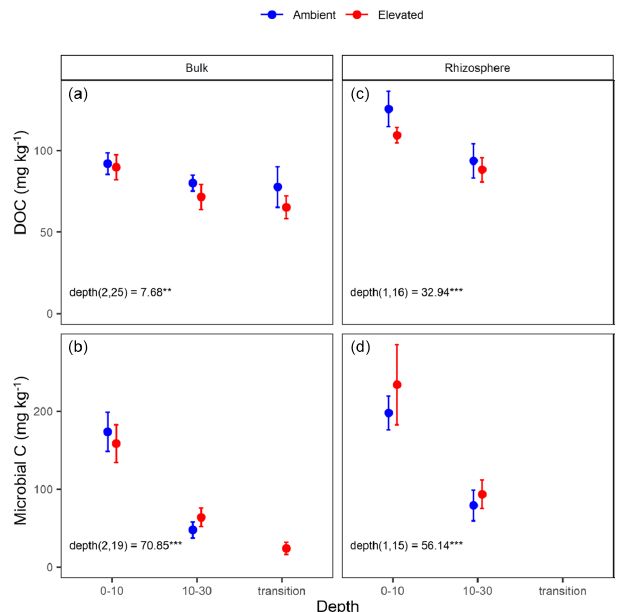
Figure 3. Dissolved organic carbon (DOC) and microbial biomass carbon (C) content for bulk and rhizosphere soil of the mature Euca- lyptus forest soil exposed to ambient (blue) and elevated (red) CO 2 for three depths (0–10 and 10–30cm and transition). Error bars in- dicate the standard error. Mixed-effects model output is stated (de- grees of freedom and Df residuals), the F statistic is presented, and asterisks for the P values for significance are as indicated, where ∗∗∗ indicate P< 0 . 001, and ∗∗ indicate P< 0 . 01. Results from the statistical analysis of comparison of soil types (bulk and rhizo- sphere) are presented in Table